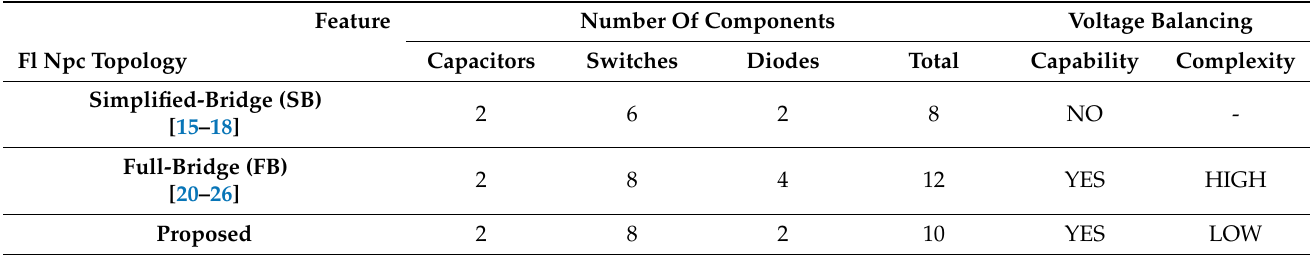
Table 1. Comparison of five-level NPC converters.